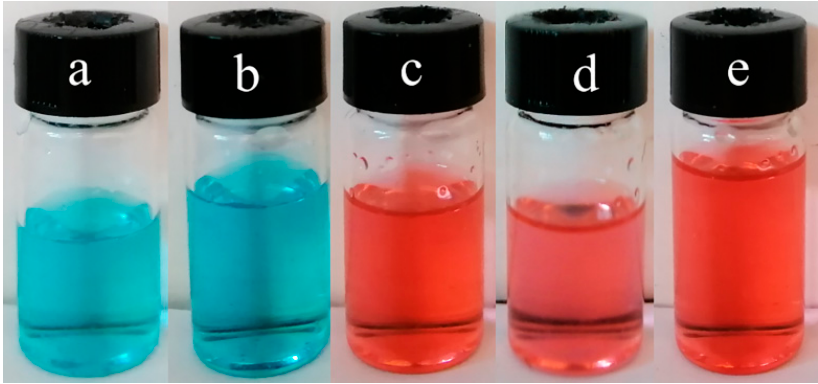
Figure 12. Liquid collected by oil and water separation at different temperatures: ( a , b ) water: ( a ) 10 °C; ( b ) 20 °C; ( c – e ) hexane: ( c ) 35 °C; ( d ) 50 °C; ( e ) 65 °C.